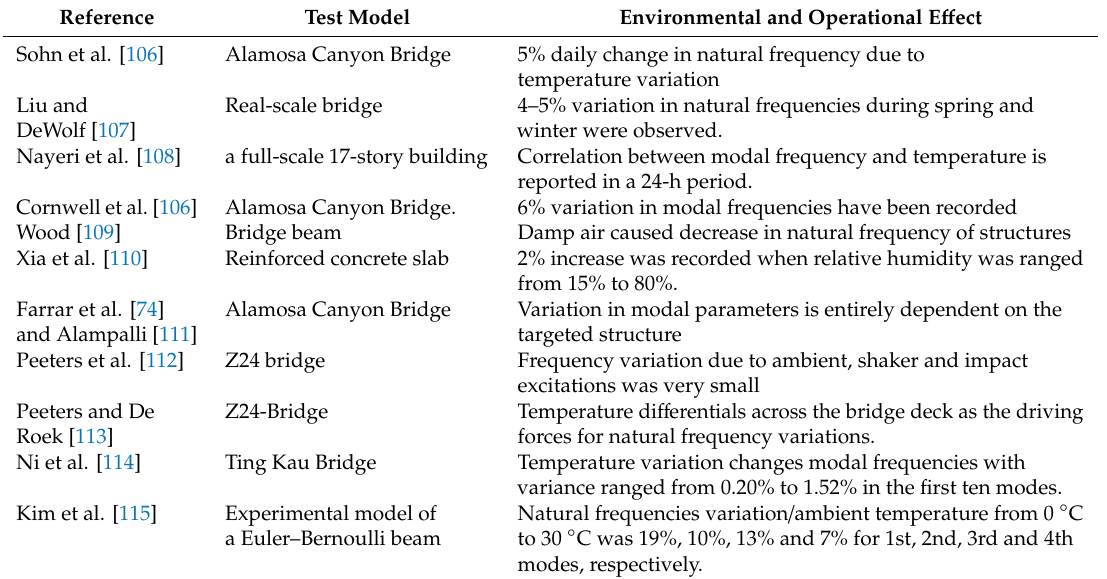
Table 2. Influence of environmental and operational condition on damage detection of